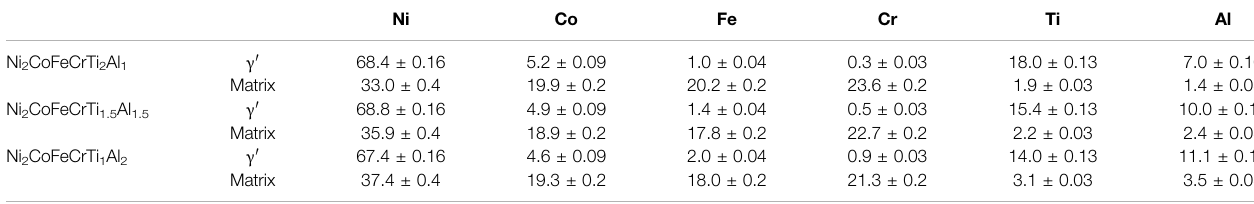
TABLE 1 | Chemical composition of γ ′ nanoparticles and matrix (at%).